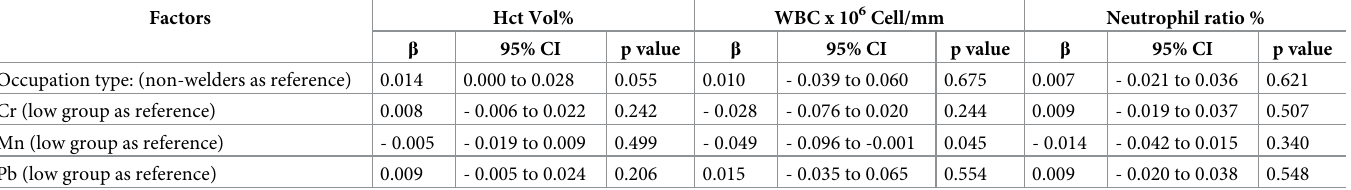
Table 5. Effects of welding fume exposure on blood hemostatic parameters. Factors